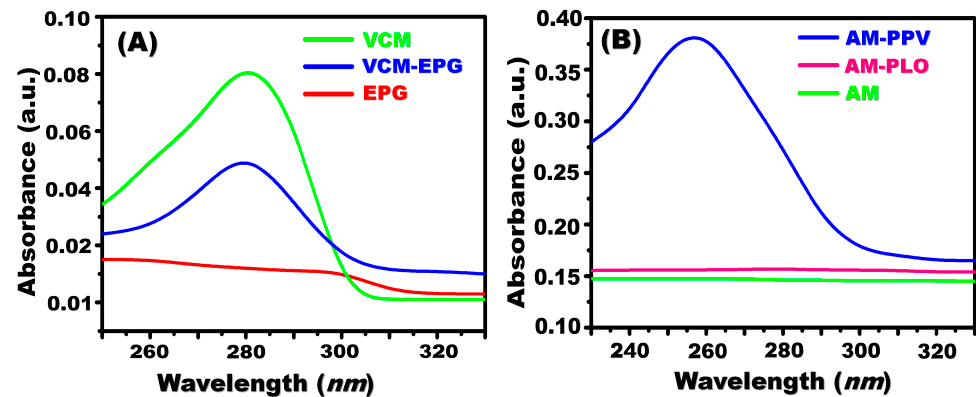
Figure 2. ( A ) UV–VIS absorption spectra of 20 µ g/mL of VCM, amine-PEG-carboxymethyl, and VCM-PEG; ( B ) UV–VIS absorption spectra of 20 µ g/mL of AM-NSs, AM-PLO, and furry AM-PPV NSs.